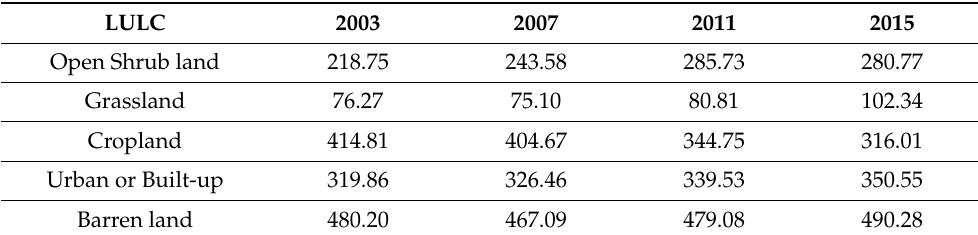
Table A1. Mean area (km 2 ) of the different LULC